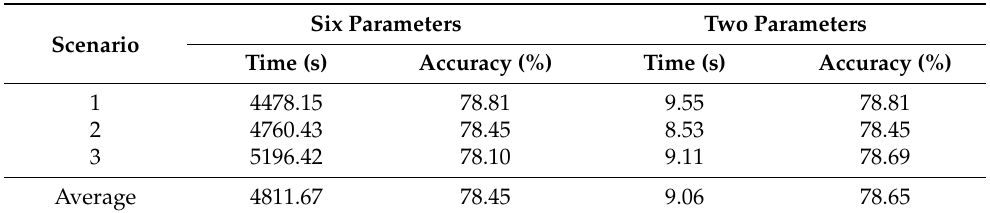
Table 8. Model’s accuracy and training time of k -NN on dataset B.